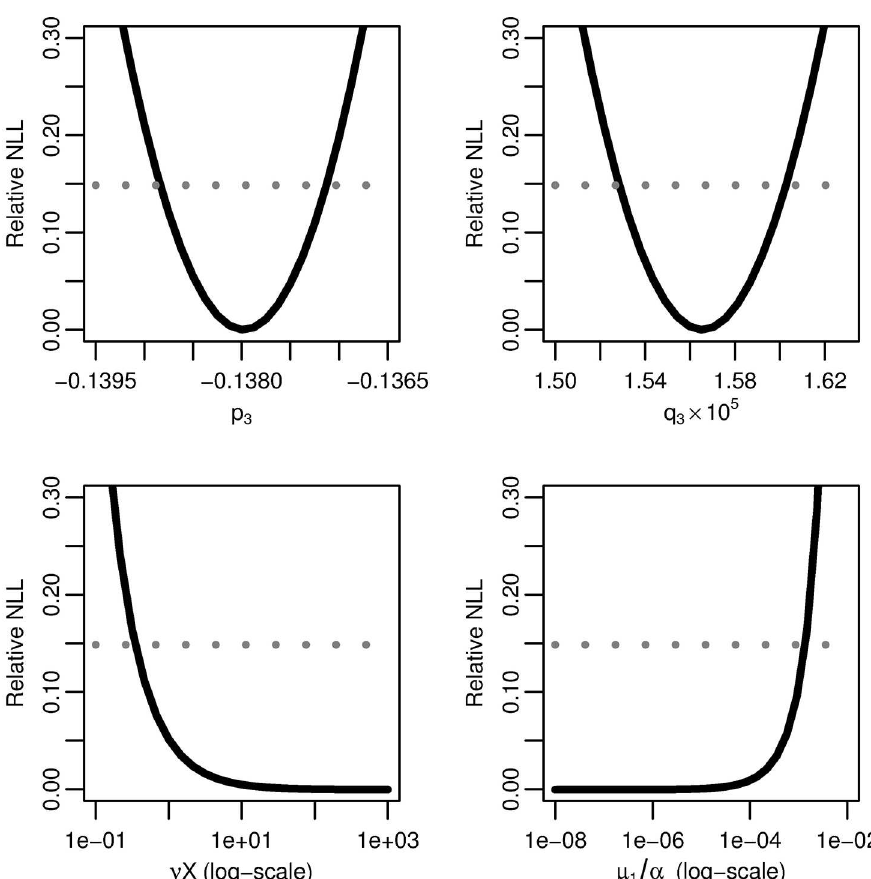
Fig 5. Three-stage model profile likelihoods. Profiles of the relativenegative log-likelihood(NLL) of the three-stage clonal expansionmodel as each of parameter combinations p 3 , q 3 , ν X , and μ 1 / α are varied while the remaining parametersare fit. The gray dotted line gives the α = 0.01 thresholdfor simultaneous confidenceintervals based on the relative negativelog-likelihood. Parameter combinations p 3 and p 4 are identifiable, while ν X and μ 1 / α are practically